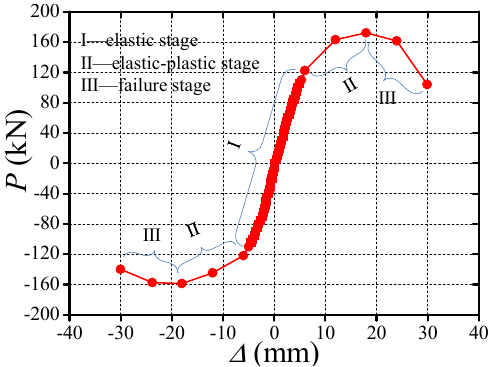
Figure 10. The skeleton curve of the RACFST frame.